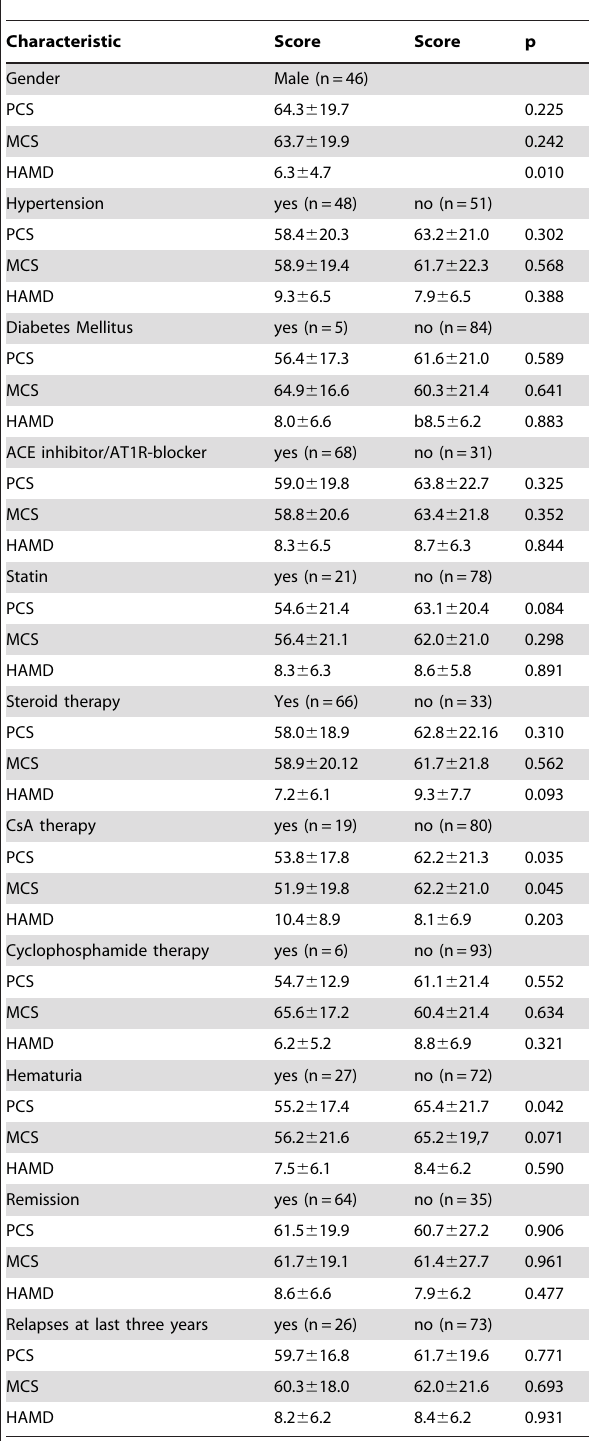
Table 3. Scores in subgroups based on several clinical